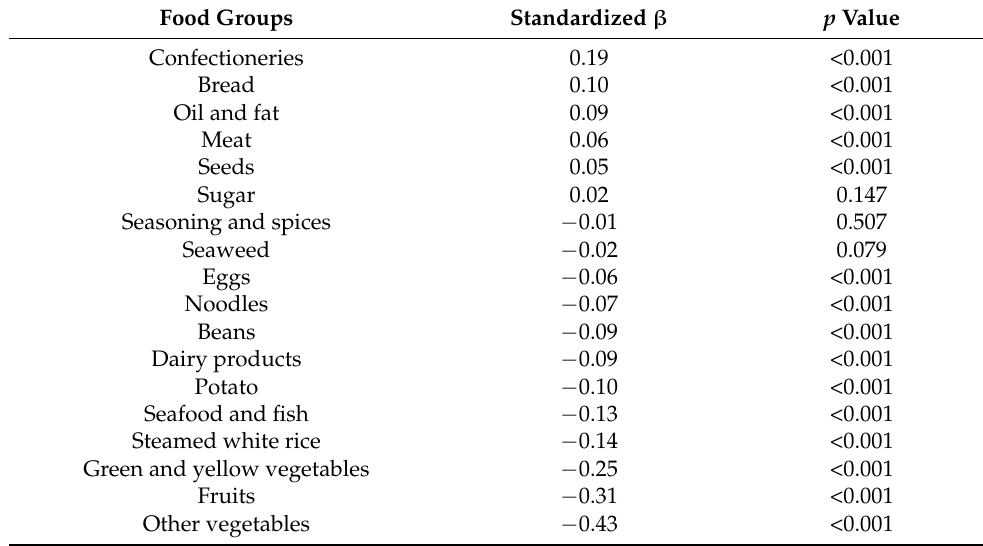
Table 5. Standardized β coefficients from multiple linear regression models for food groups